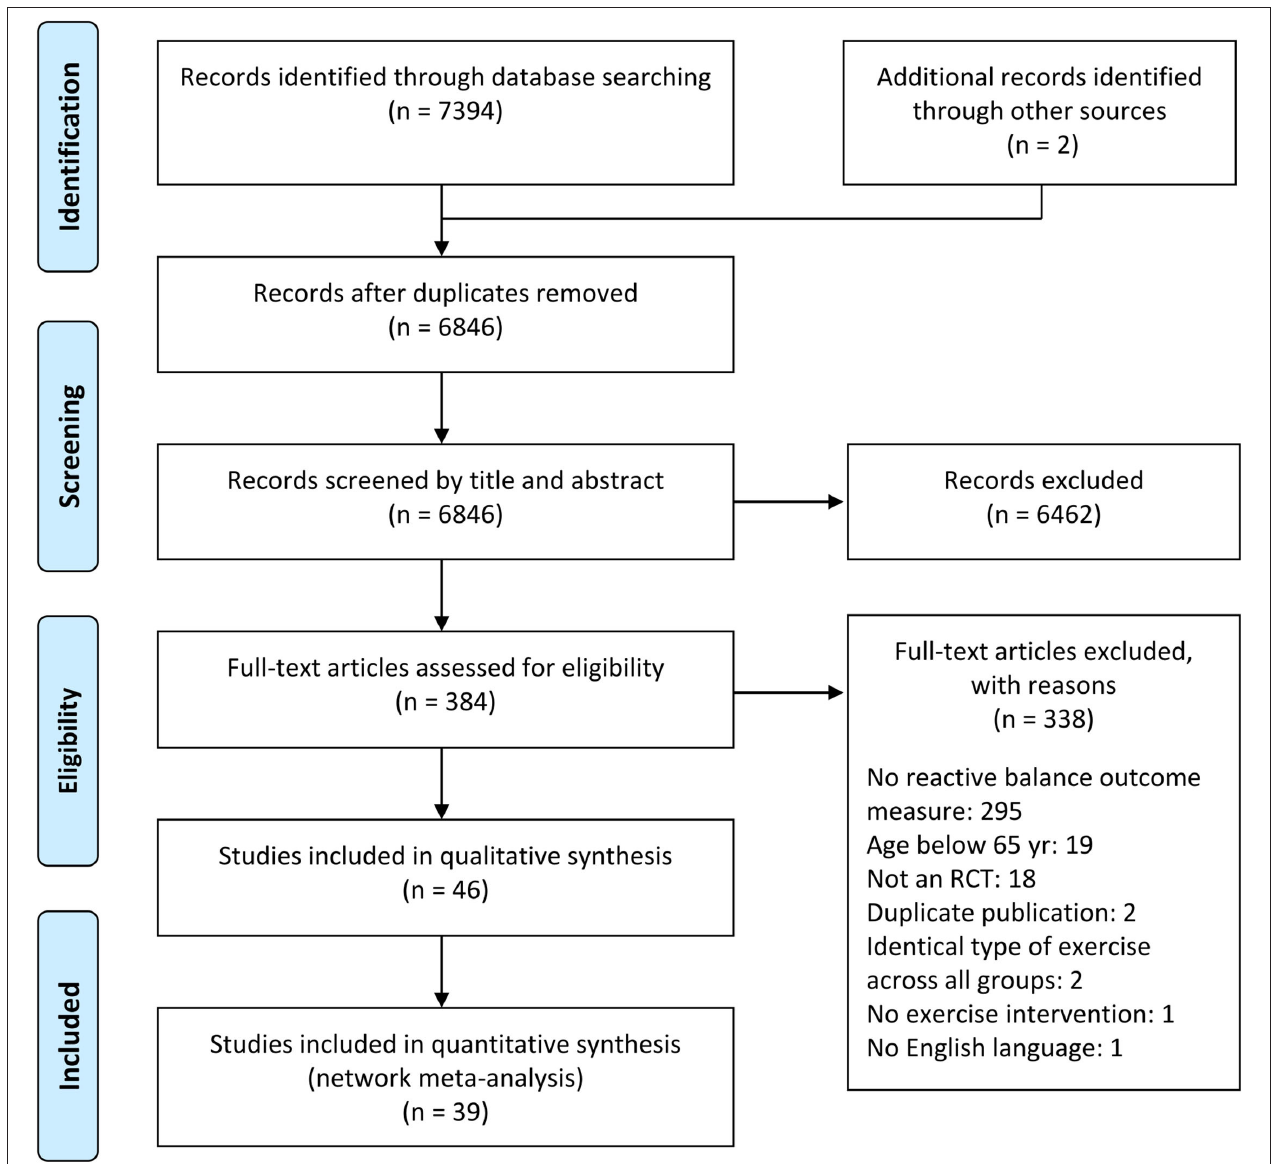
FIGURE 1 | PRISMA flow diagram of study